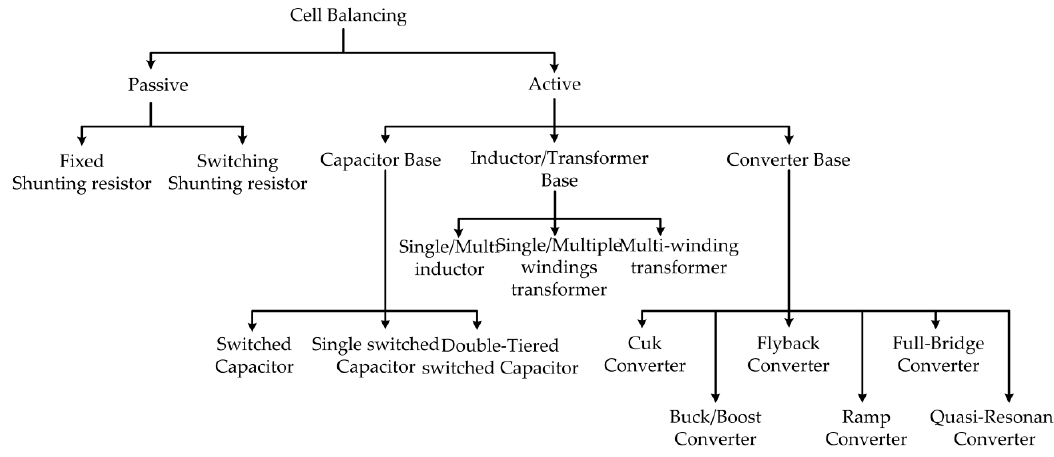
Figure 1. The classifications of conventional battery cell balancer [21].